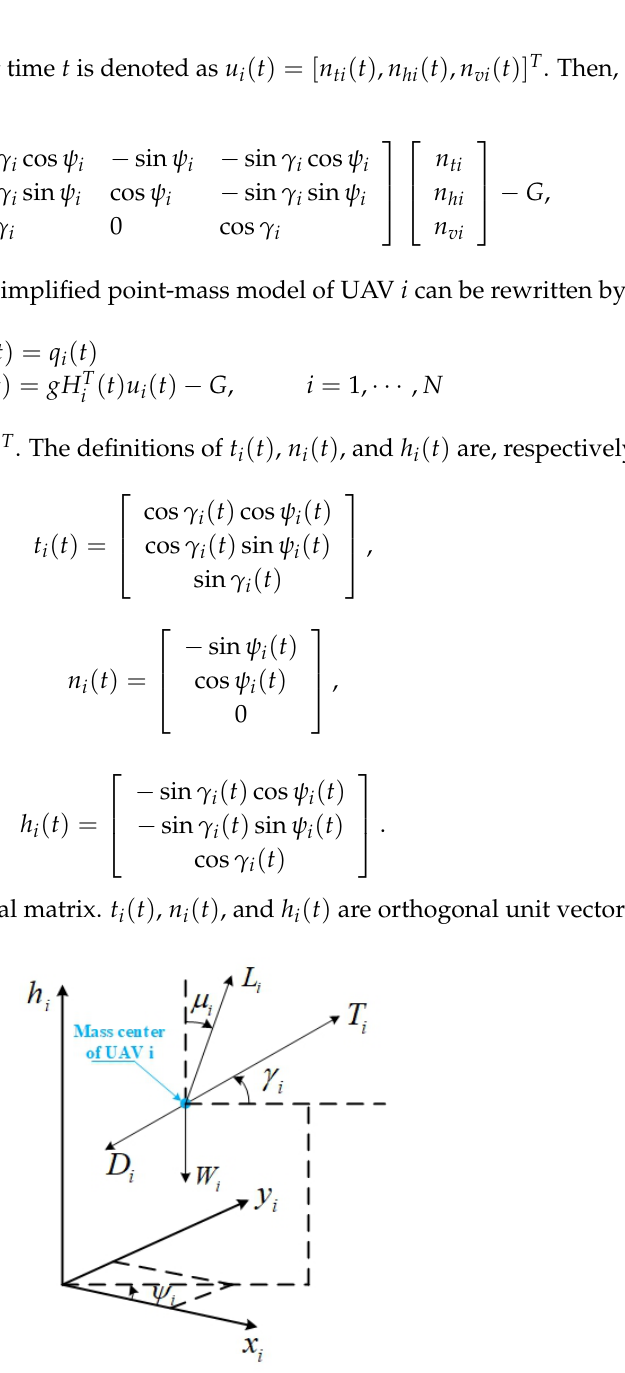
Figure 1. The simplified dynamical model of Unmanned Aerial Vehicle (UAV) i